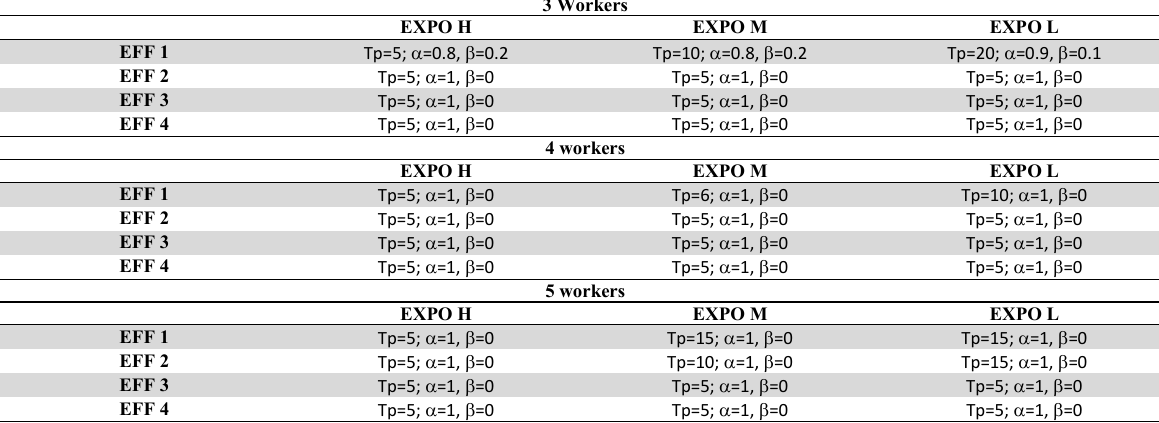
Best cases of Tp,  and  values